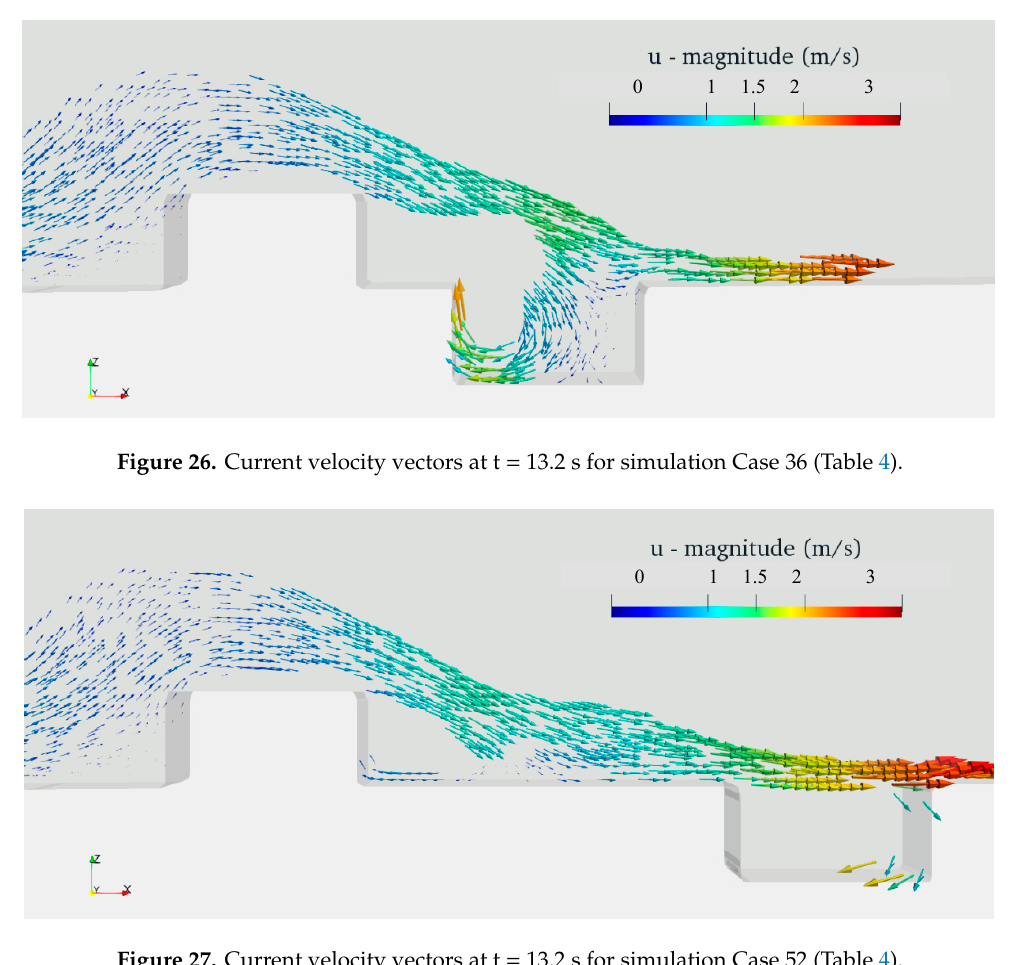
Figure 25. Current velocity vectors at t = 13.2 s for simulation Case 24 (Table 4).